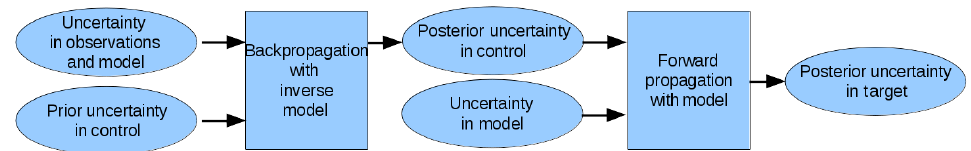
Figure 1. Two-step procedure of QND formalism. Ovals denote data, rectangles denote processing.